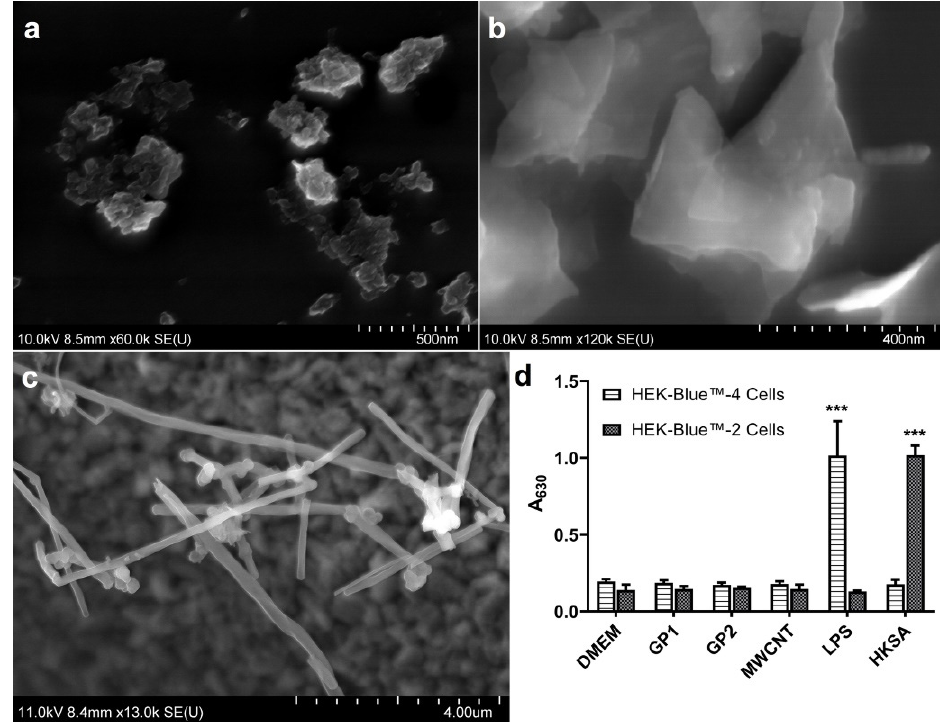
Figure 1. Characterisation of C-BNM: ( a ) SEM image of GP1 forming small aggregates; ( b ) SEM image of GP2 forming large sheets; ( c ) SEM detail of MWCNTs’ structure; ( d ) HEK-Blue™ cells respond to C-BNMs. Data are presented as median with 95% CI. *** p < 0.001 highlights statistical significance as compared to untreated control (DMEM).